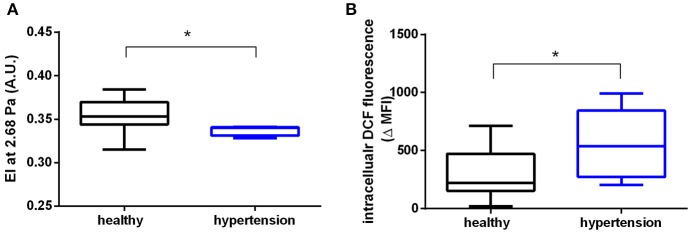
RBCs from patients with hypertension display decreased RBC deformability and increased ROS levels. (A) Decreased elongation index (EI) measured in RBCs of hypertensive (n = 4) and healthy (n = 9) participants at a shear stress of 2.68 Pa. *Mann-Whitney-U test, p < 0.05. (B) Increased levels of ROS in RBCs of hypertensive participants (n = 9) measured as intracellular dichlorofluorescein (DCF) fluorescence values and compared to healthy controls (n = 11) (MFI, median fluorescence intensity; ΔMFI = MFI of loaded RBCs—MFI unloaded RBCs) *Mann-Whitney-U test, p < 0.05. All ektacytometric measurements were carried out from whole blood diluted in PVP solution and measured in a range of shear stresses of 0.3–10 Pa.